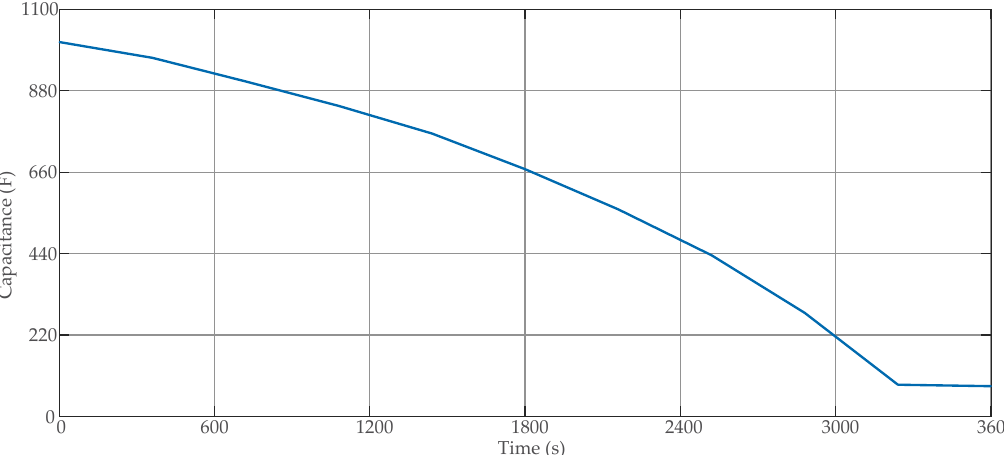
identification and L